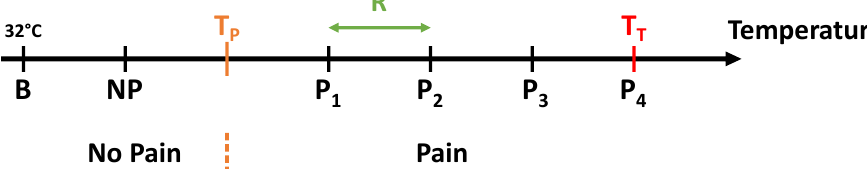
Figure 3. The 5 temperature intervals defined by the temperature range R in dependency of T P and T T . While the first temperature resembles a non-painful stimulus, the last 4 are meant to evoke pain.